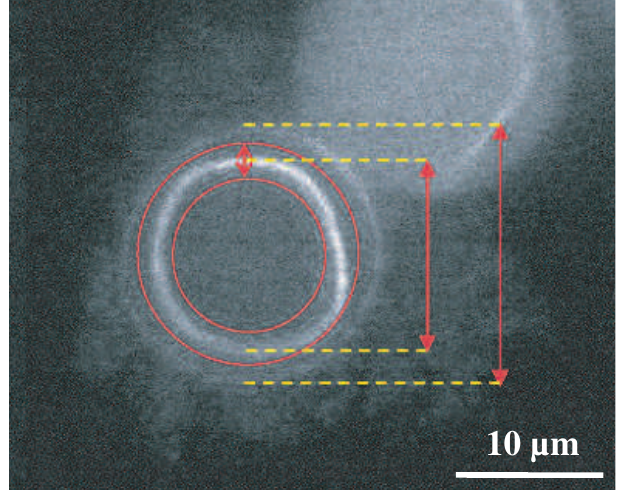
Figure 5. Analysis of thermal fluctuations of the actin bundle backbone (white circular shape) revealed different bending stiffnesses depending on the type of the crosslinkers. The two red circles mark the region the bundle can occupy in the time course of its thermal fluctuations. The picture is taken from Claessens et al.